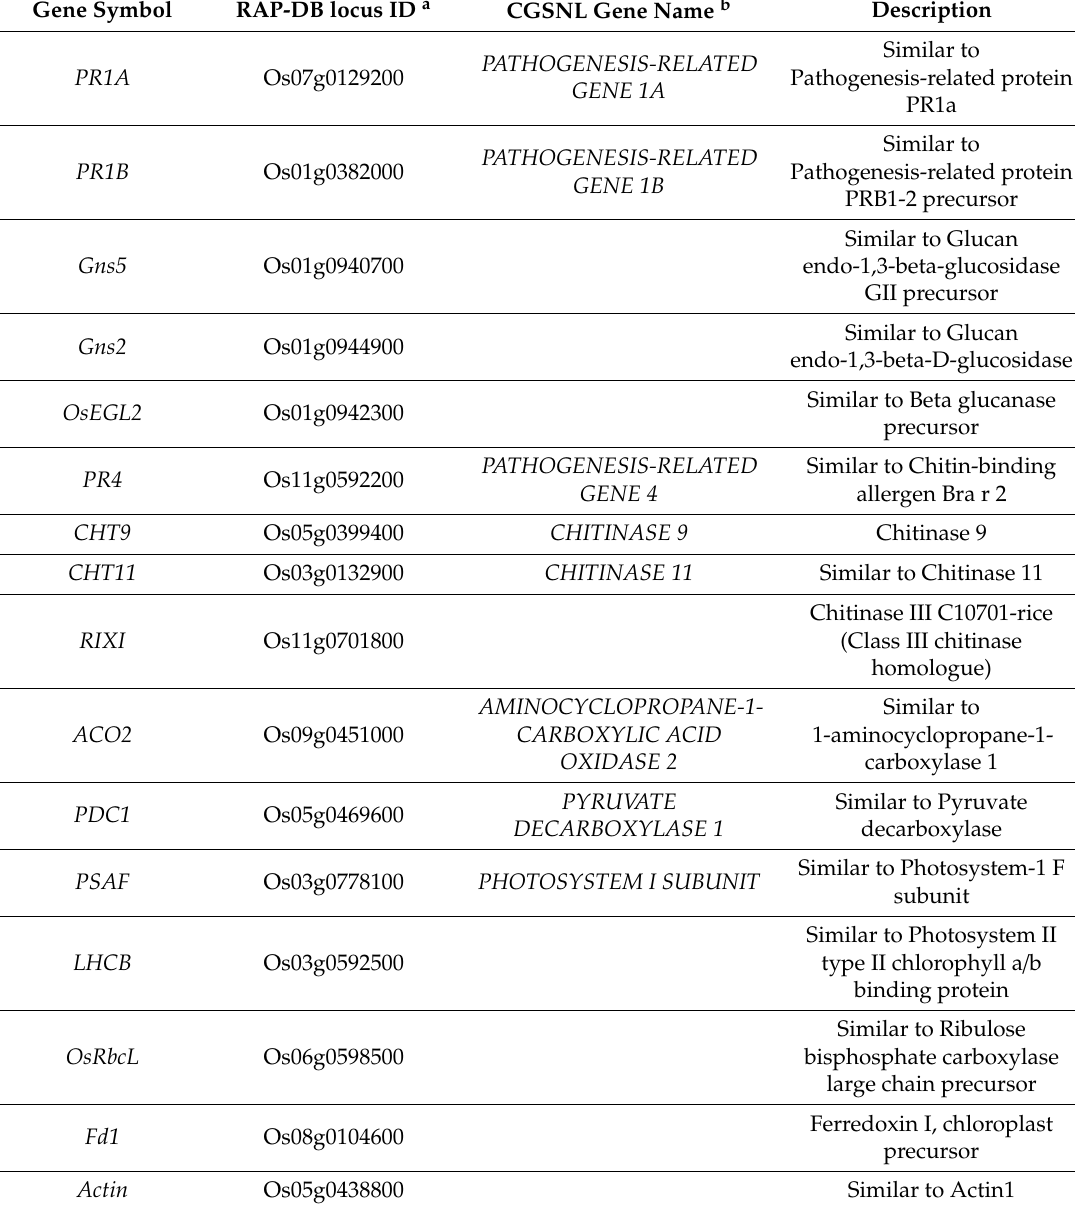
Table 1. Genes analyzed for